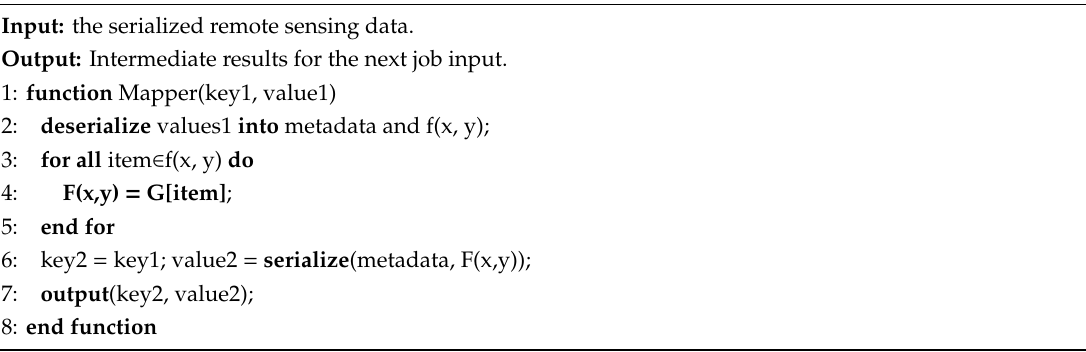
Algorithm 1: The cloud computing model for Numerical Calculation